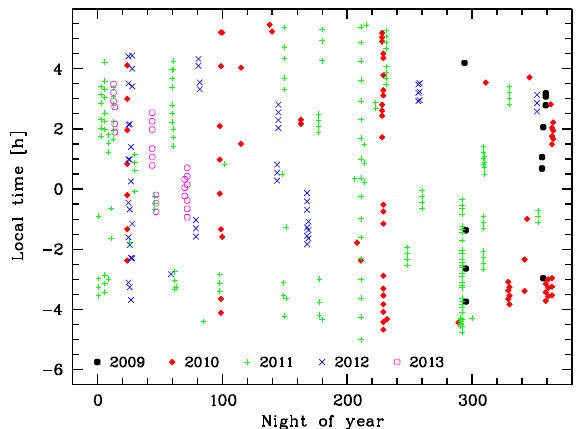
Figure 1. Sample of 343 X-Shooter observations used in this study. The local time, i.e. Universal Time (UT) corrected for the longitude of Cerro Paranal, is shown vs. the night of year. The latter is the day of year for the second half of the night. The different years of the observations are identified by different symbols and colours (see legend at the bottom of the